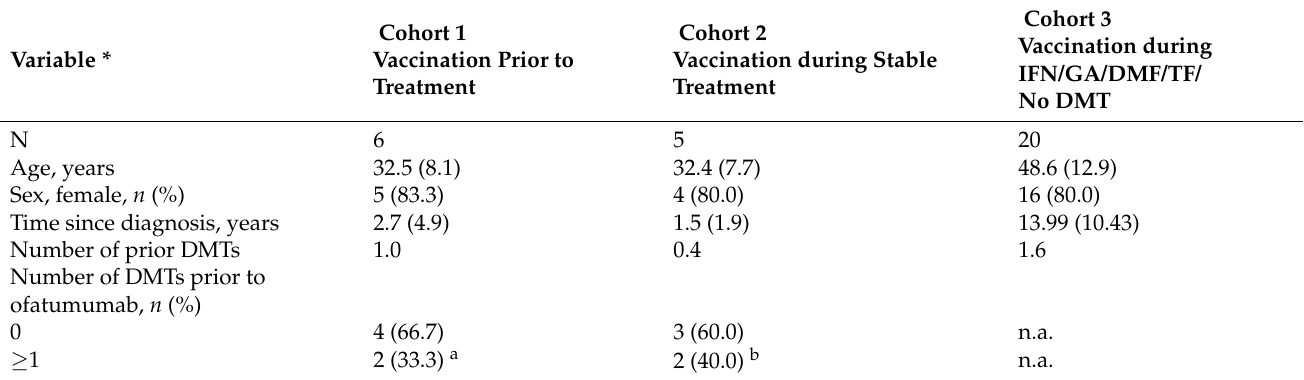
Table 1. Demographic and disease characteristics.